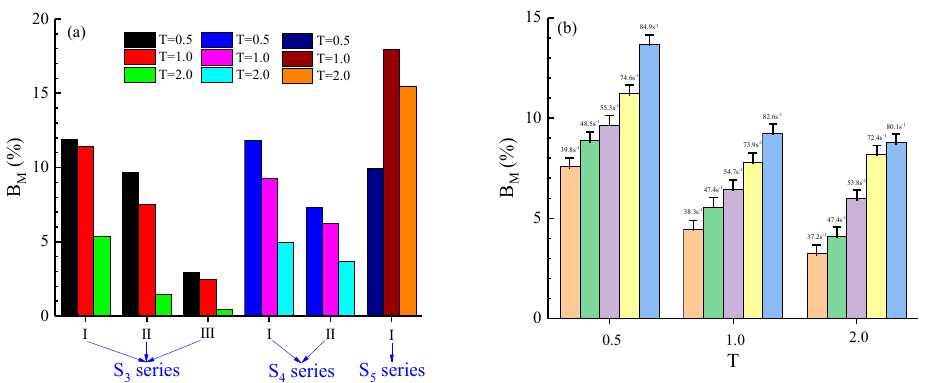
Figure 15. Breakage ratio B M of cemented rock samples: ( a ) various PSD; ( b ) various strain rates.